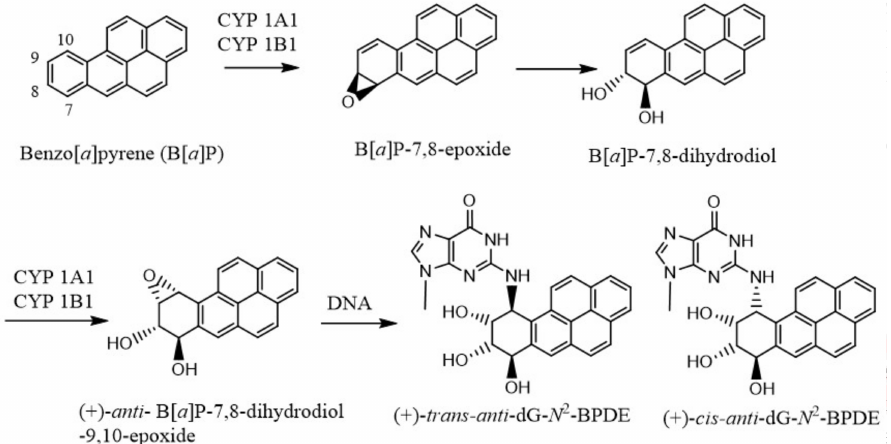
Figure 1. Microsomal metabolic activation of benzo[ a ]pyrene to its most reactive (+)- anti -B[ a ]P-7,8- dihydrodiol-9,10-epoxide, which reacts with DNA to form the dG